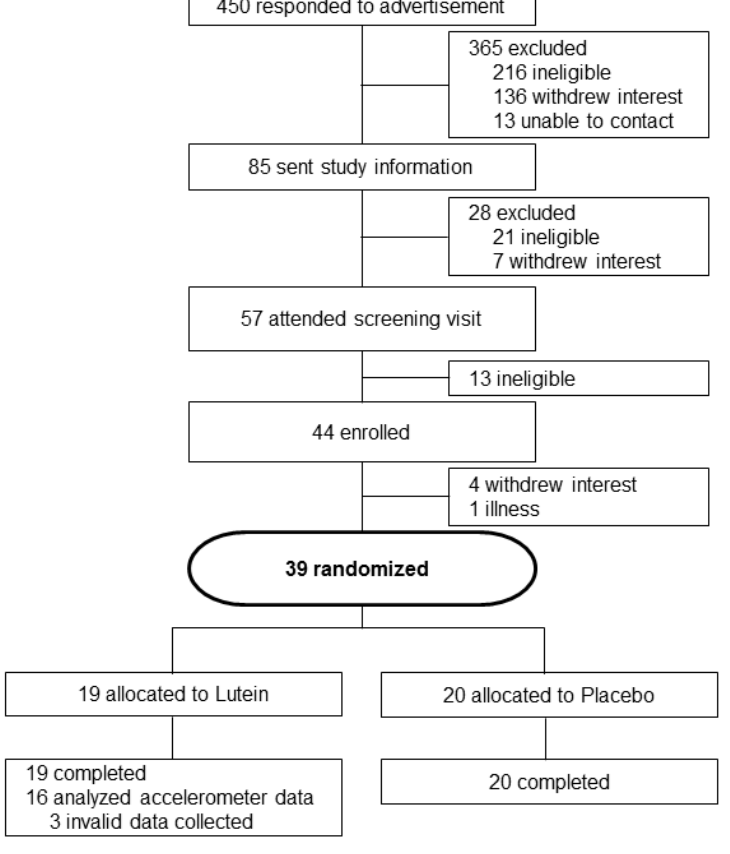
Figure 1. CONSORT Diagram of participant flow from recruitment to analysis of the